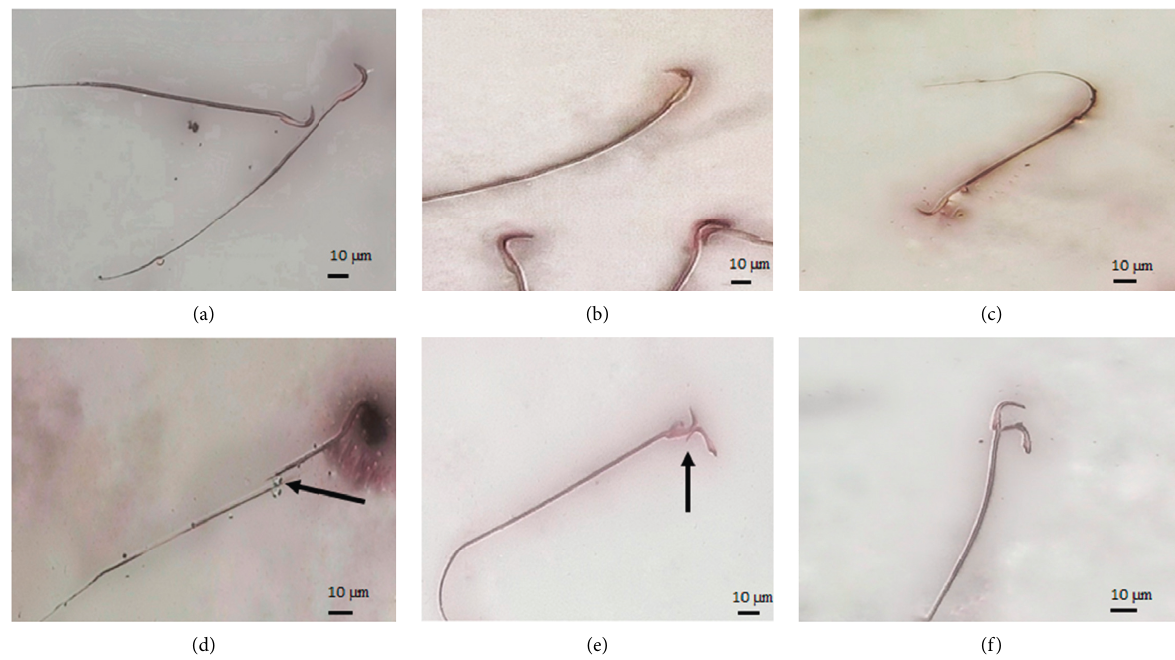
Figure 2: Sperm morphology in lansoprazole treated rats at 2.5, 5, and 10mg/kg/day (40 x). (a) Normal sperm, (b) banana head sperm, (c) bent tail sperm, (d) amorphous head with a broken tail, (e) detached head, and (f) double